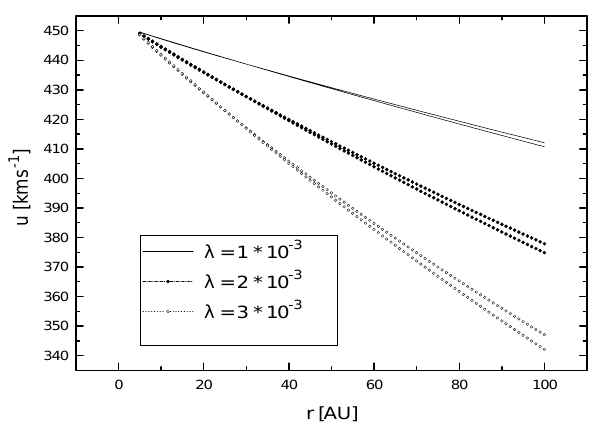
Fig. 2. Shown is the solar wind velocity profile resulting for dif- fererent values of the parameter 3 and r =30. In all cases the as- sociated dashed curve gives a comparison to the pressure-less case (i.e. α pui = 0 )